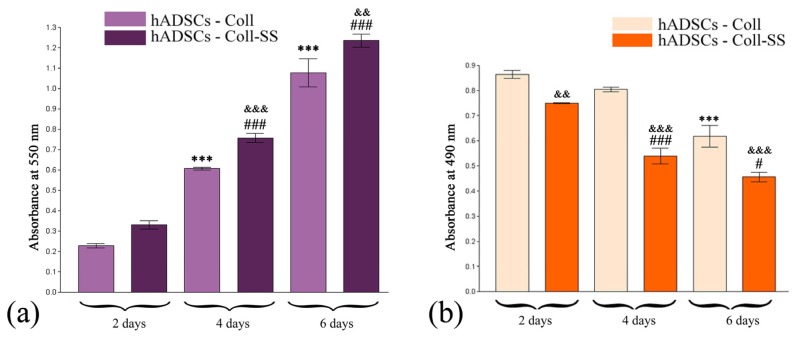
The quantification of (a) hADSCs proliferation rate in Coll and Coll-SS biomatrices as revealed by MTT test. *** p < 0.001 (Coll bioconstruct: 4 days vs. 2 days and 6 days vs. 4 days); ### p < 0.001 (Coll-SS bioconstruct: 4 days vs. 2 days and 6 days vs. 4 days); && p < 0.01 (Coll-SS bioconstruct vs. Coll bioconstruct: 6 days); &&& p < 0.001 (Coll-SS bioconstruct vs. Coll bioconstruct: 4 days)]; (b) the cytotoxic potential of Coll and Coll-SS biomatrices on hADSCs as revealed by LDH assay. *** p < 0.001 (Coll bioconstruct: 6 days vs. 4 days); # p < 0.05 (Coll-SS bioconstruct: 6 days vs. 4 days); ### p < 0.001(Coll-SS bioconstruct: 4 days vs. 2 days); && p < 0.01 (Coll-SS bioconstruct vs. Coll bioconstruct: 2 days); &&& p < 0.001 (Coll-SS bioconstruct vs. Coll bioconstruct: 4 days and 6 days).